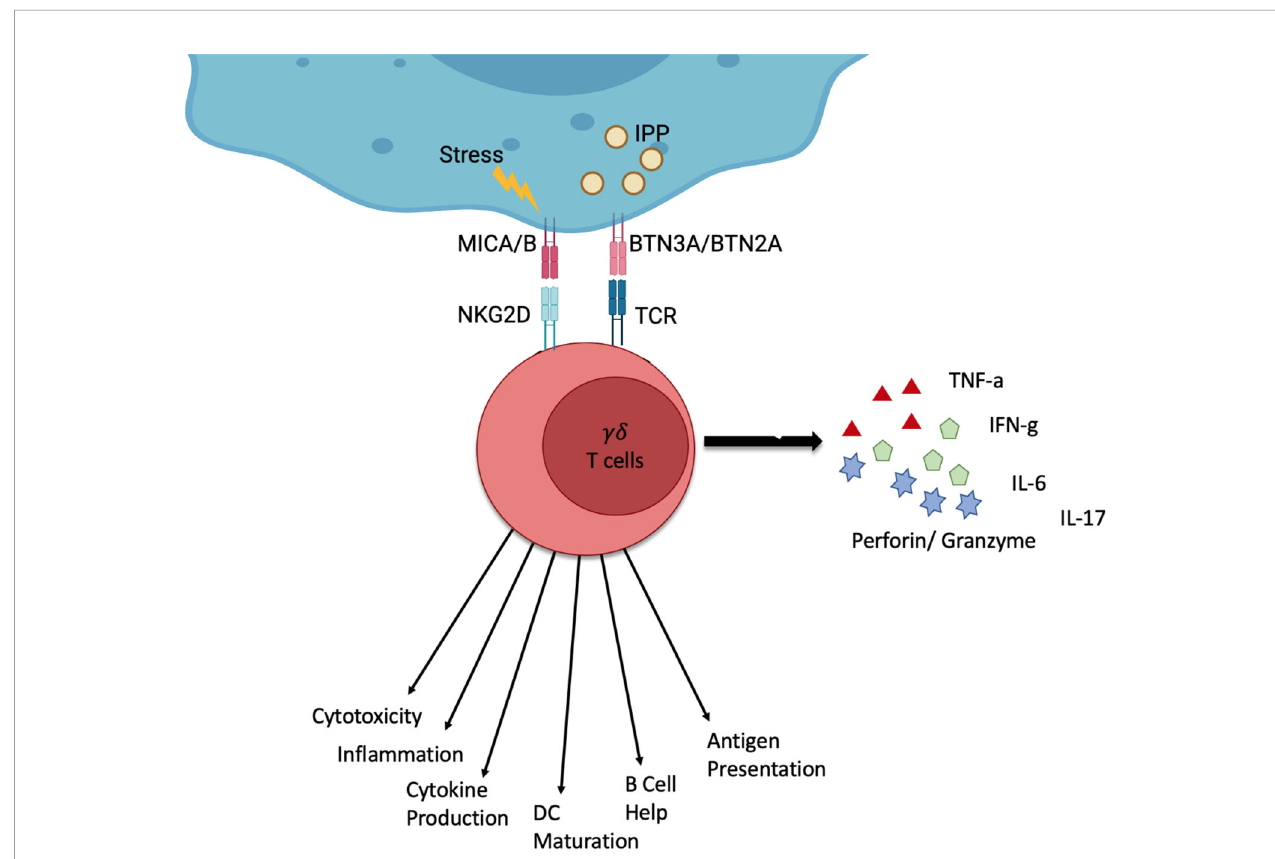
FIGURE 1 | Schematicofthe function of gd T cells. gd T cells can beactivatedby stress signals from infectedortumour cells. Stressed or infected cellscan express MICA andMICB which gd T cells can recognise via the NKG2D receptor. Furthermore, the overexpression of certainmolecules such as IPP can berecognised through the gd TCR byrecognising BTN3A and BTN2A on stressed or infected cells. gd T cells can respond via different channels. This can bethe production of cytokines (IFN- g , TNF- a , IL-6, IL-17)orcytolysis(Perforin,Granzyme).Additionally, gd T cells can interact with other immune cells andpresent antigens. Createdby